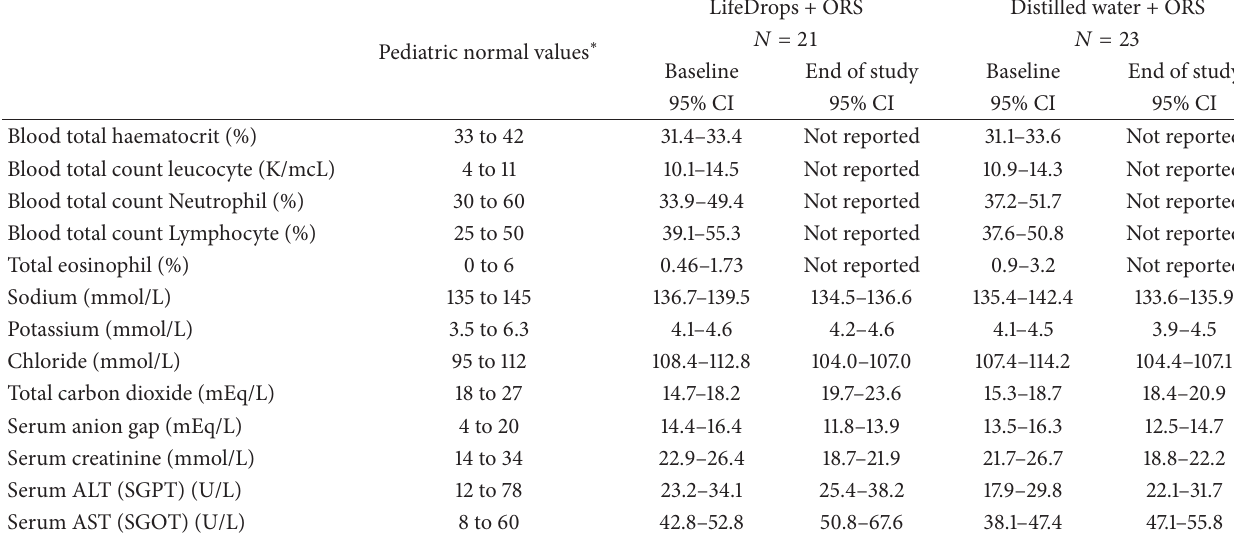
Table 6: Results from testing of blood samples for various factors in patients aged 6 to 23 months.